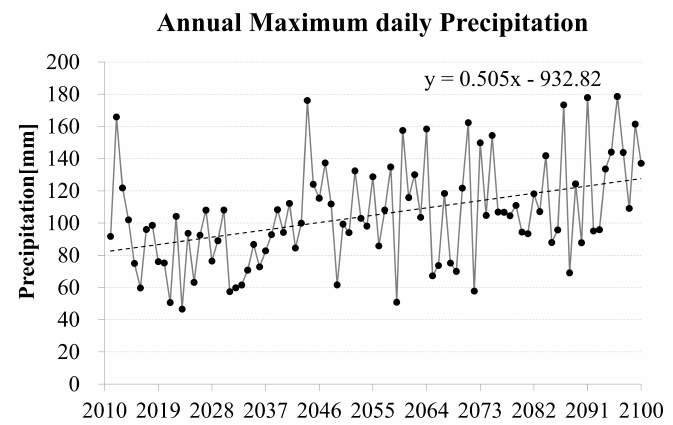
Figure 9. Projection of daily maximum precipitation.